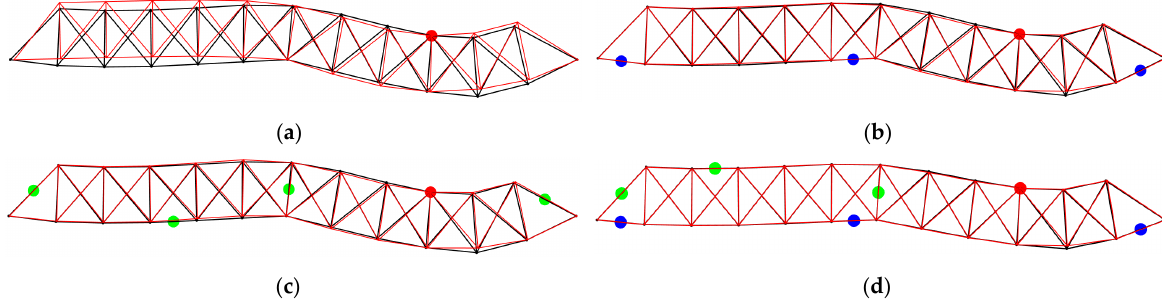
Figure 25. Example of estimated deformed shape according to the sensor number and combination (RDS4): ( a ) number of data ( ω = 1 ), ( b ) number of data ( ω = 1, ∅ = 3 ), ( c ) number of data ( ω = 1, ε = 4 ), ( d ) number of data ( ω = 1, ∅ = 3, ε = 3 Table 9. Sensor location in the FEM model used for estimation (strain with displacement)—truss. Displacement (Node)